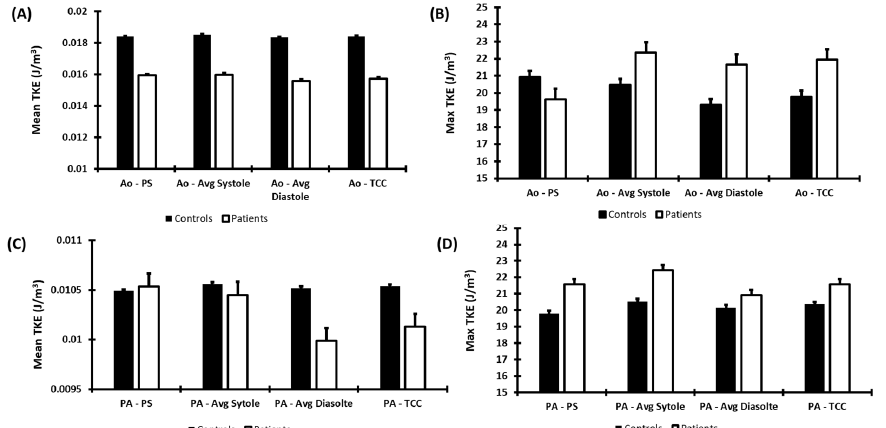
Figure 3. Turbulent kinetic energy in the aorta and pulmonary artery. Mean turbulent kinetic energy (TKE) and max TKE were calculated throughout the entire cardiac cycle, including peak systole (PS), average systole (avg systole), average diastole (avg diastole), and total cardiac cycle (TCC) in the Aorta (Ao) and Pulmonary Artery (PA) for both patients and controls. Panel ( A ) shows mean TKE in the Ao. Panel ( B ) shows max TKE in the Ao. Panel ( C ) shows mean TKE in the PA, and Panel ( D ) shows max TKE in the PA. No statistical significance was observed between the two cohorts in either the Ao or the PA.